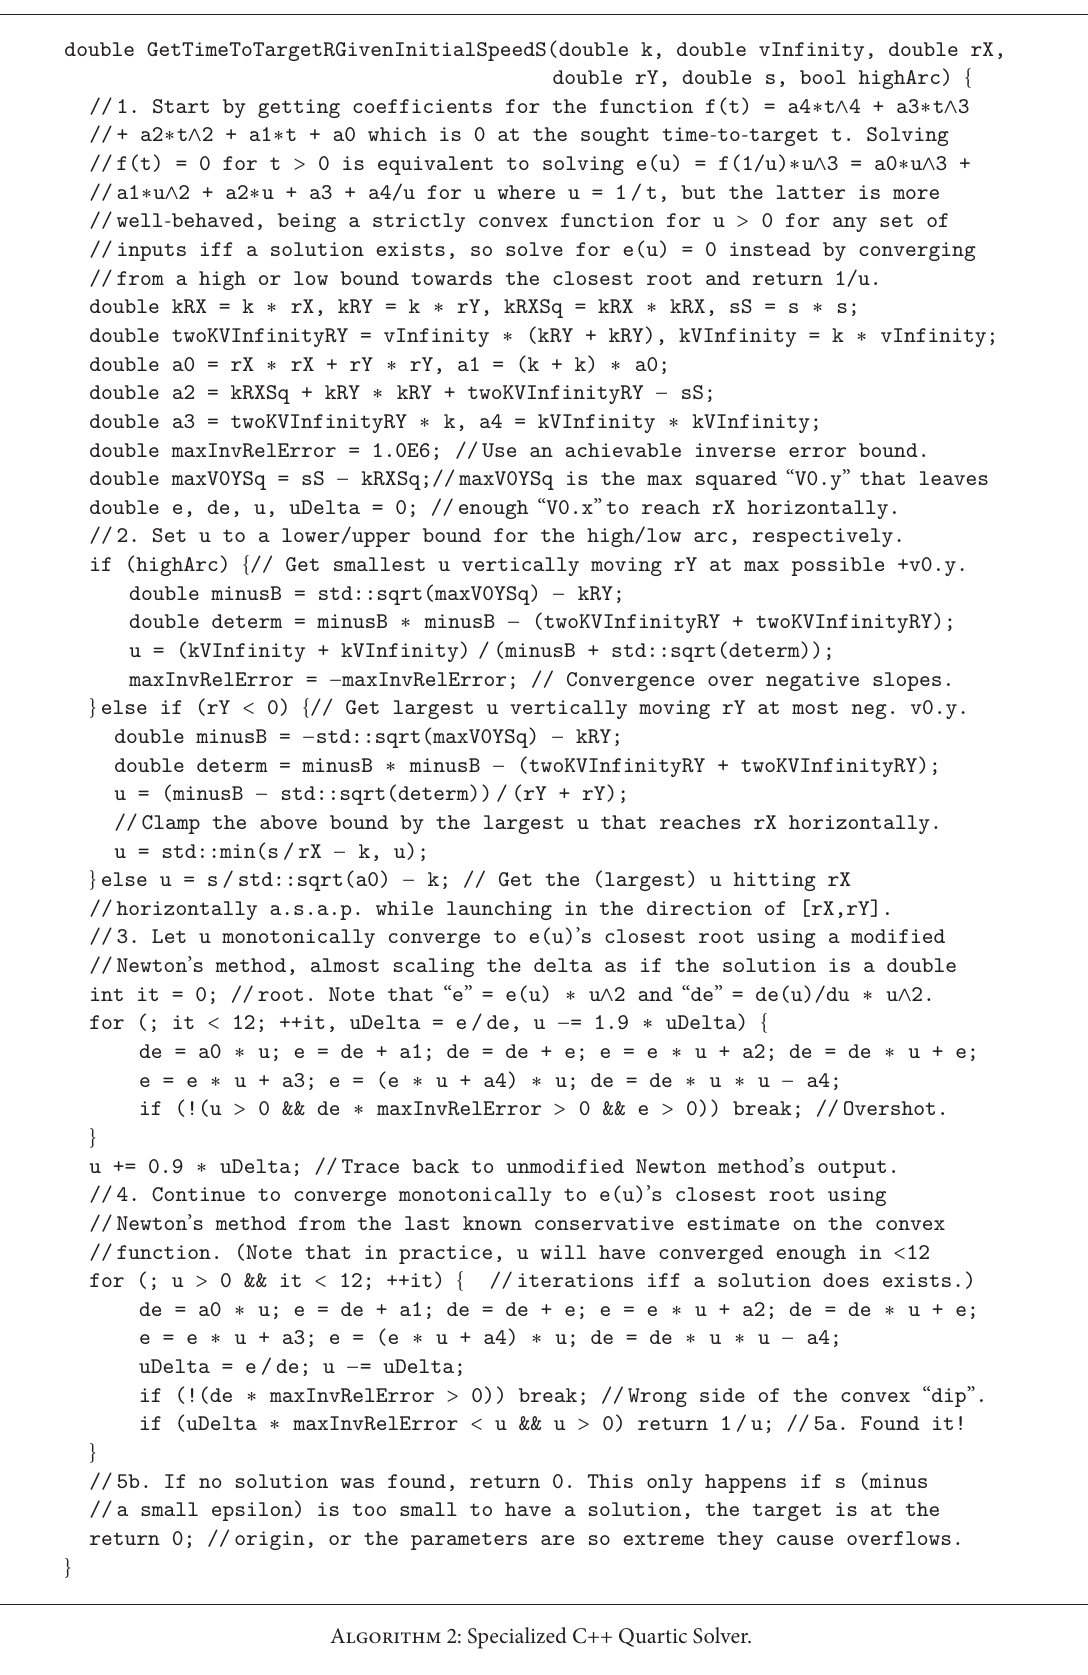
Algorithm 2: Specialized C++ Quartic